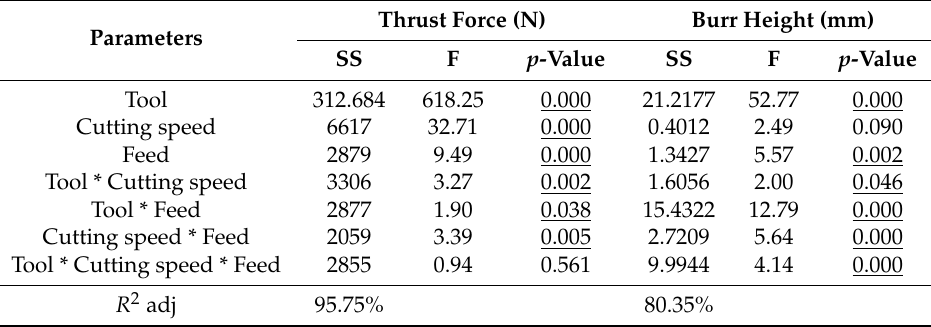
Table 4. Analysis of variance (ANOVA) for thrust force and burr